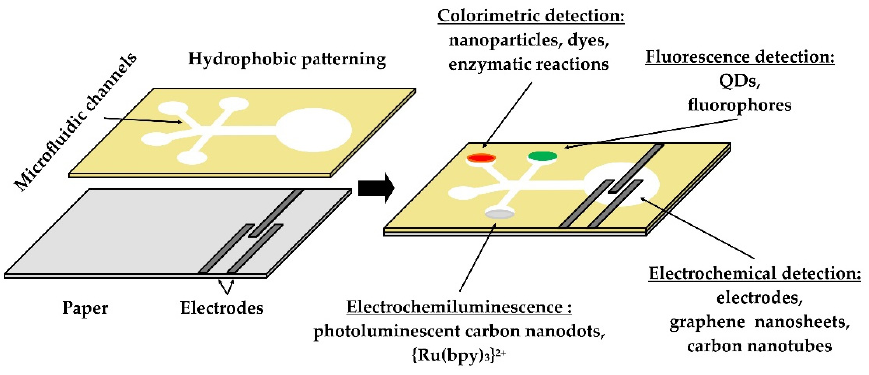
Figure 3. Concept and popular detection methods of paper-based microfluidic devices. The hydrophobic patterning determines the fluidic properties of these devices.